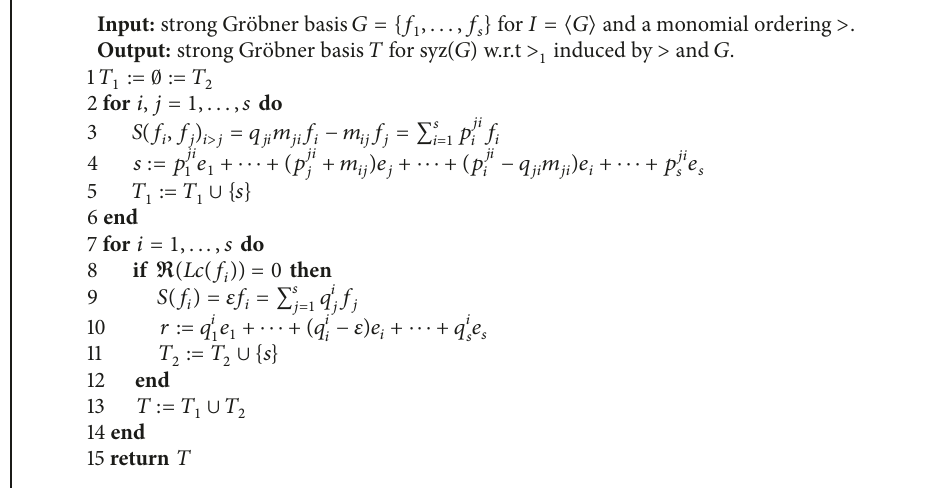
Algorithm 3: Gr¨obner basis for syz (𝑓 1 ,. .. ,𝑓 𝑠 )